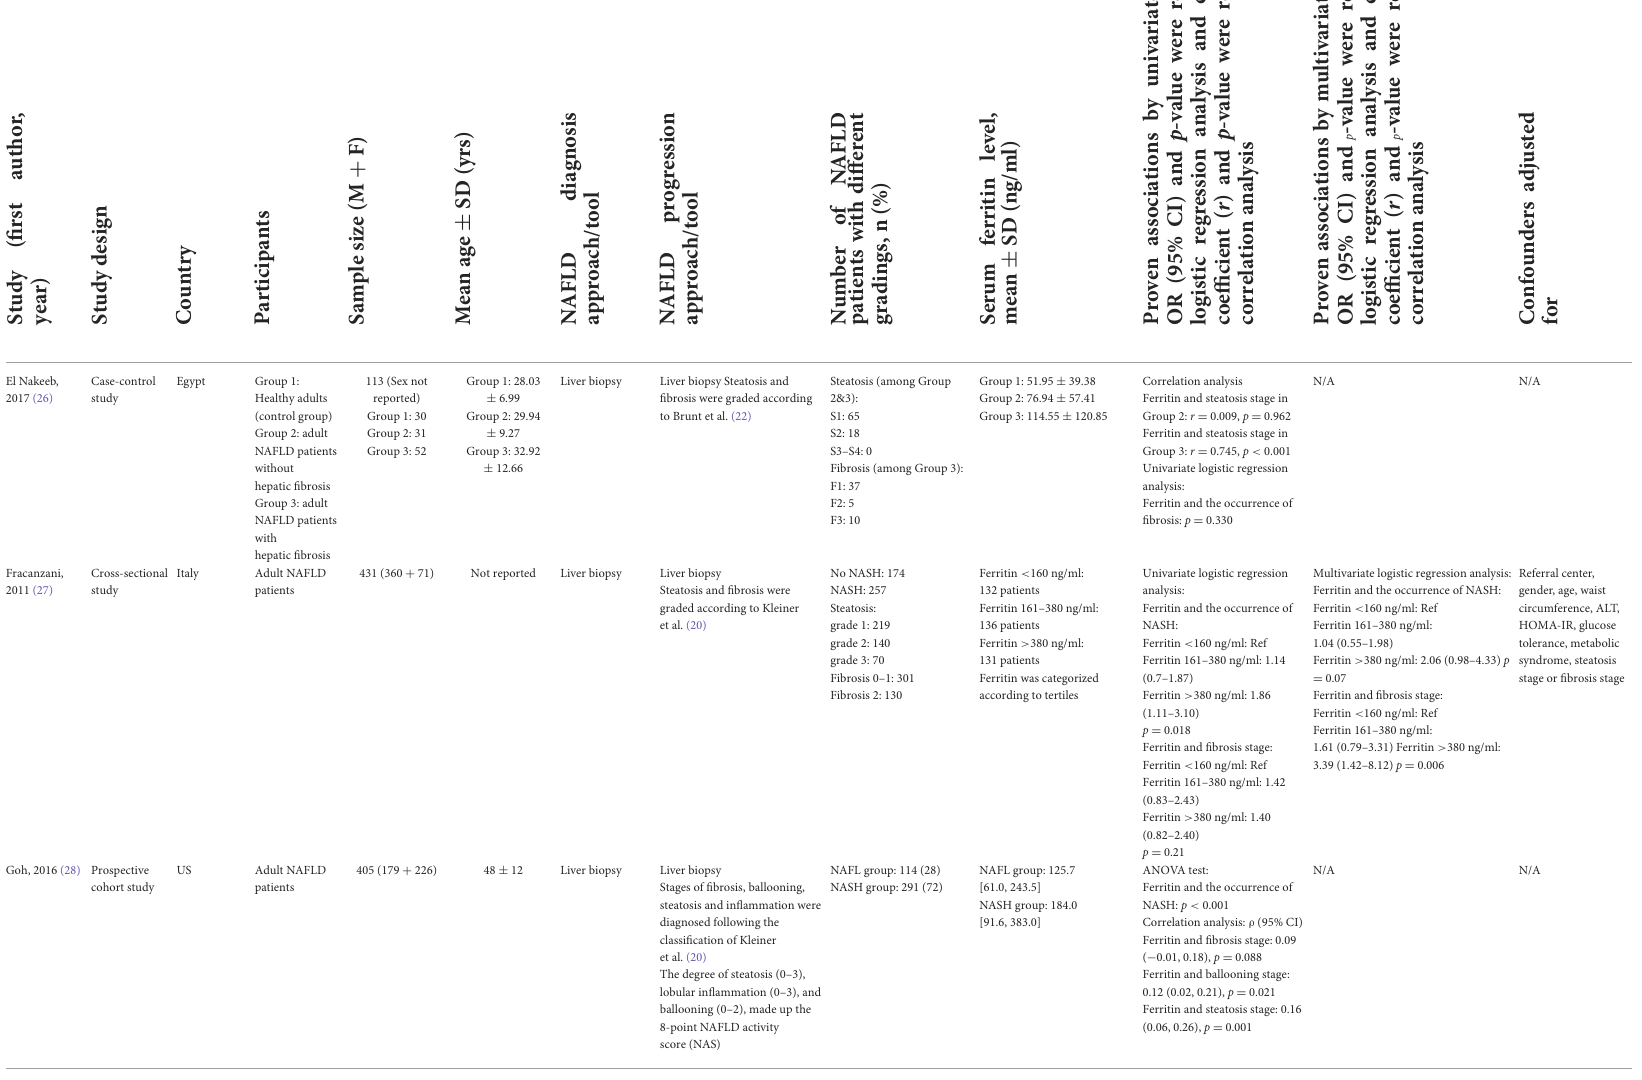
Fibrosis0–1:301 Fibrosis2:130